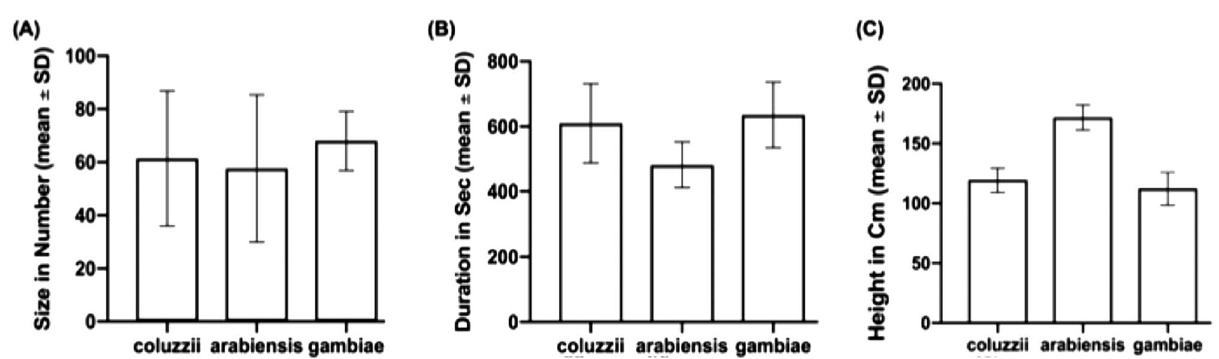
Figure 2. Characteristics of Anopheles gambiae s.l. reproductive swarm by species. ( A ) Swarm size; ( B ) Swarming duration; ( C ) Swarming